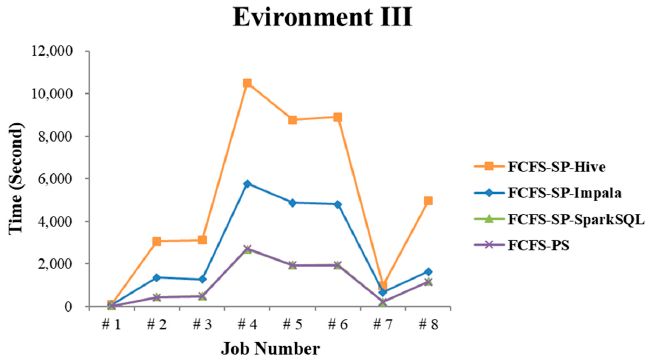
Figure 32. Execution time of each use case in test environment III. Table 13. Performance comparison among the methods for Case 2 (unit: s).